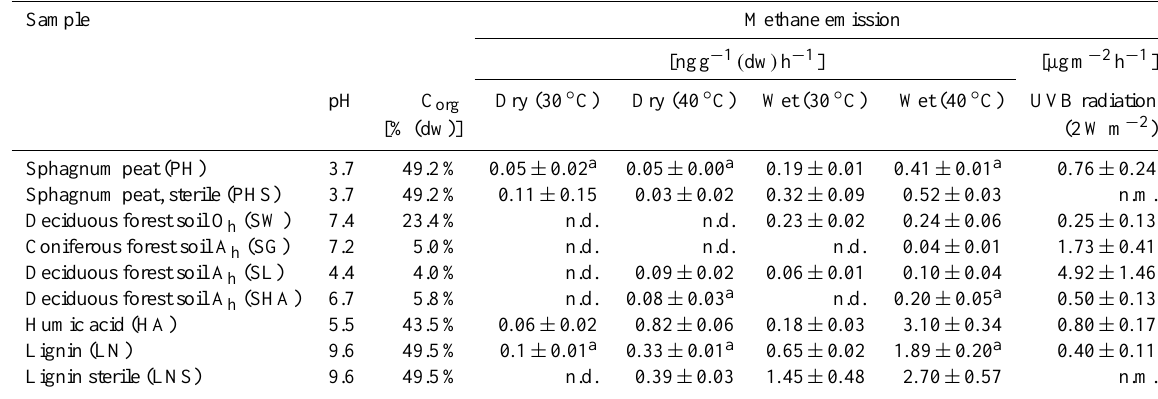
Table 1. Organic carbon content, pH value and CH 4 emissions from dry and wetted samples heated at 30 and 40 ◦ C and under UV irradiation of different soils and soil components at 30 ◦